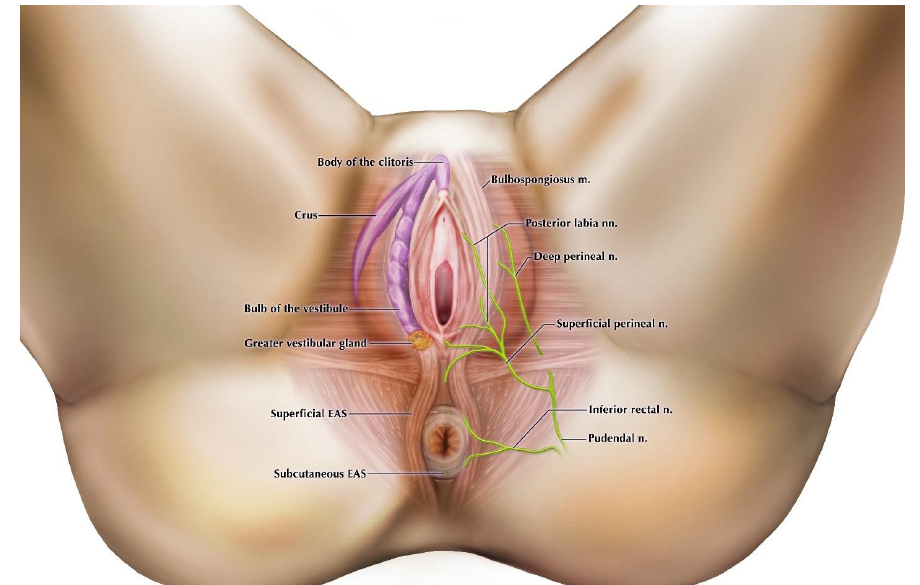
Figure 3. Representative anatomy of the perineum based on our dissections. Most commonly, the perineal body was not a major site of muscle attachment. The bulbospongiosus muscle was continuous with the superficial portion of the external anal sphincter (EAS), both innervated by branches of the perineal nerves. The inferior rectal nerve innervated the subcutaneous EAS and skin around the anus. The bulb of the vestibule extended to the posterior fourchette, with the greater vestibular gland anchored to its posterior margin.